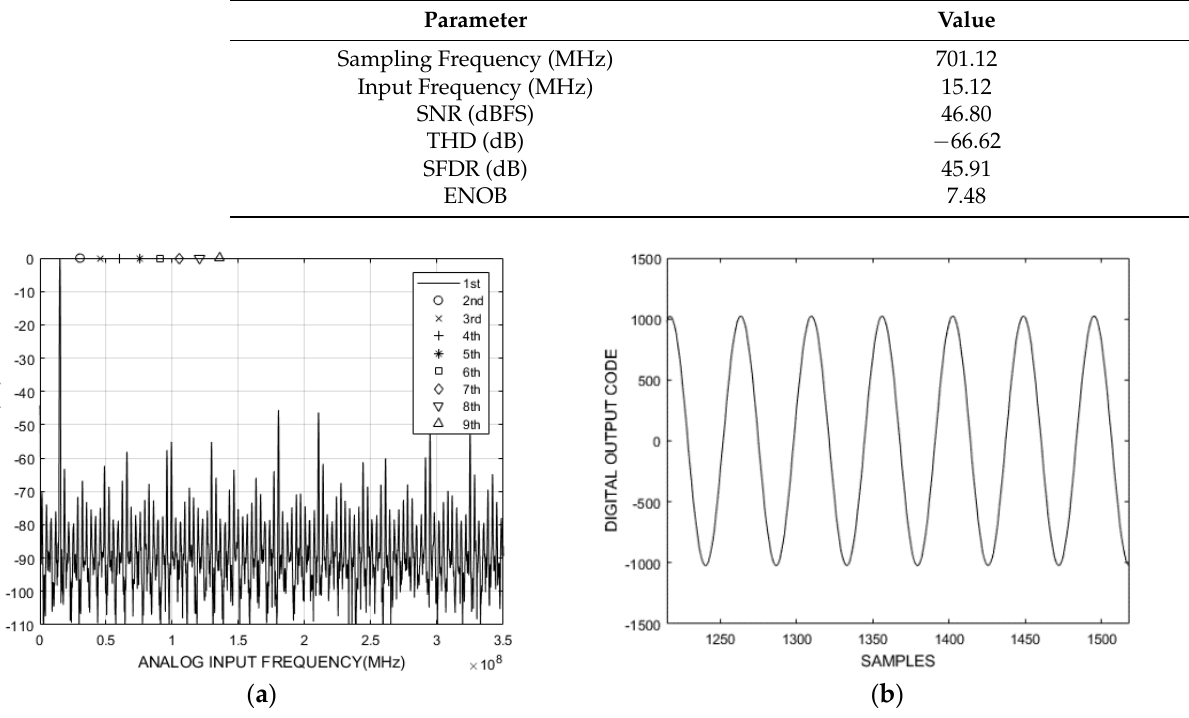
Table 1. Un-interpolated resampling results.